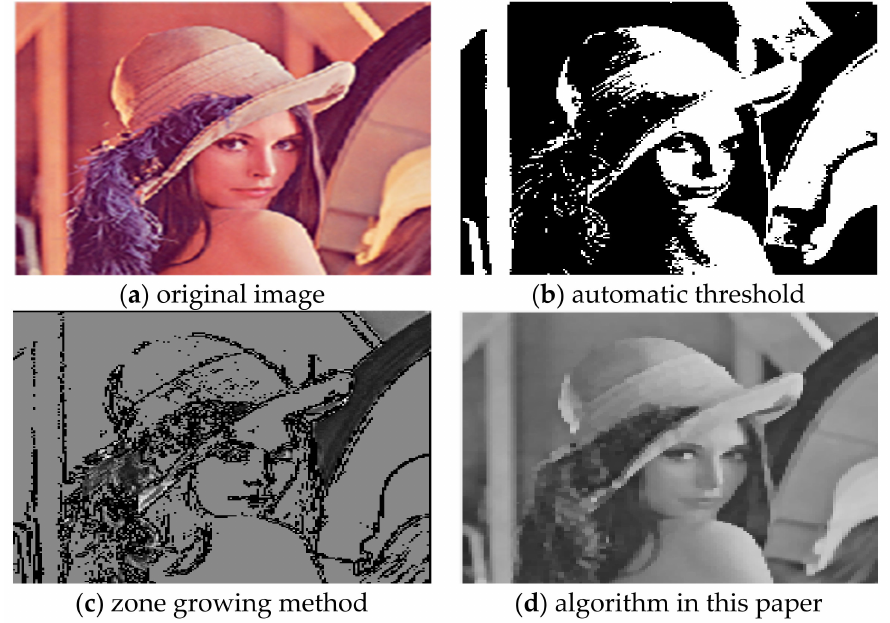
Figure 3. Comparison of segmentation results of Lena images.